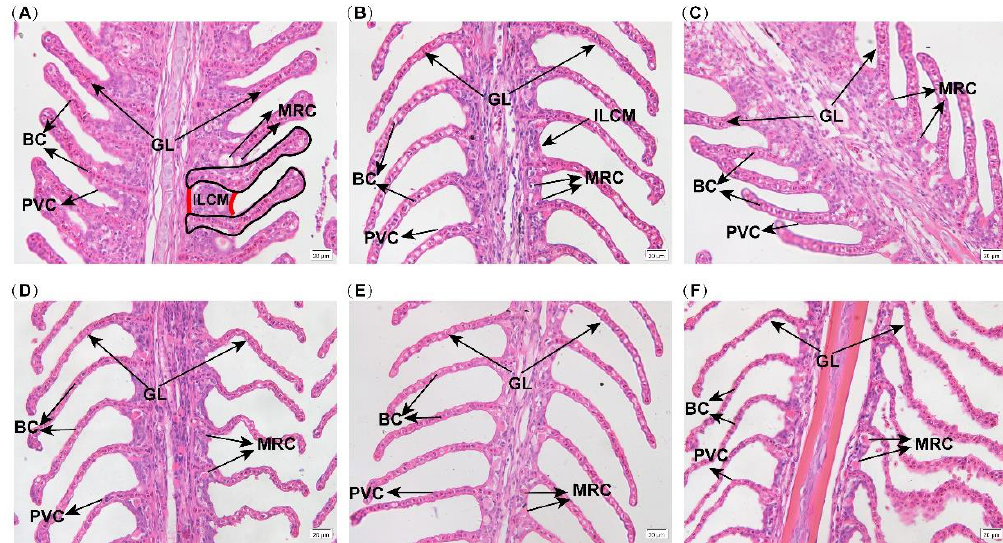
Figure 1. LM micrographs of the gill under hypoxia. The pictures are 0 hours of control ( A ), and 1 3 h ( C ), 6 h ( D ), 12 h ( E ), 24 h ( F ) of hypoxia. The length of the scale bar of ( A – F ) represents 20 µ m.